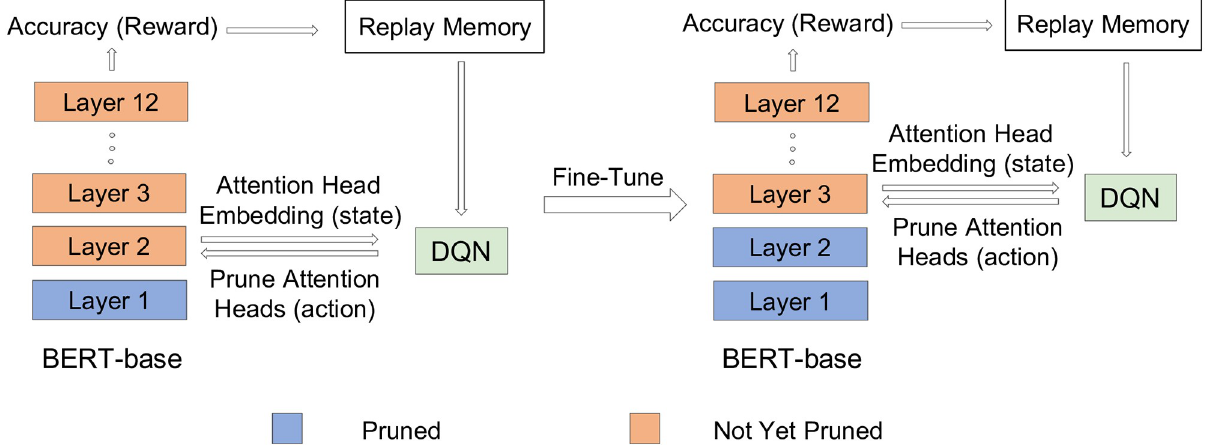
Fig 2. Overview of transitioning in AUBER. The figure shows the transition from Layer 2 to Layer 3 in AUBER with BERT-base.